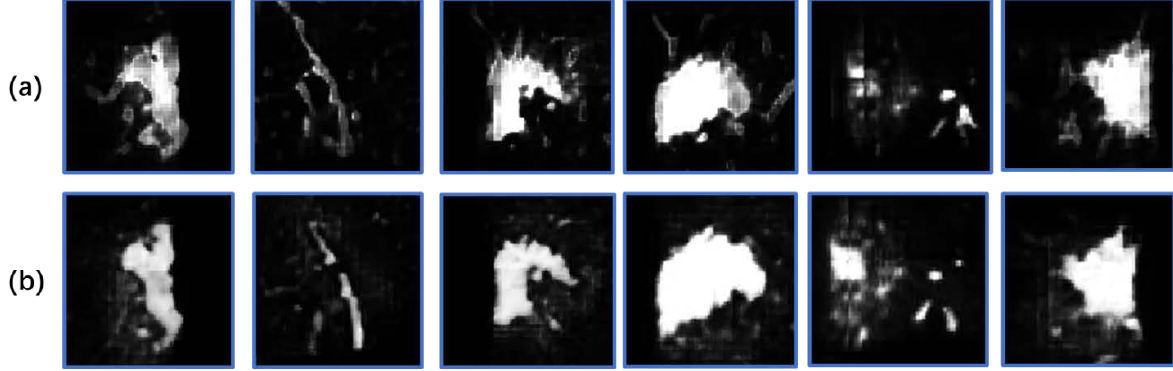
tained with data enhancement. with data